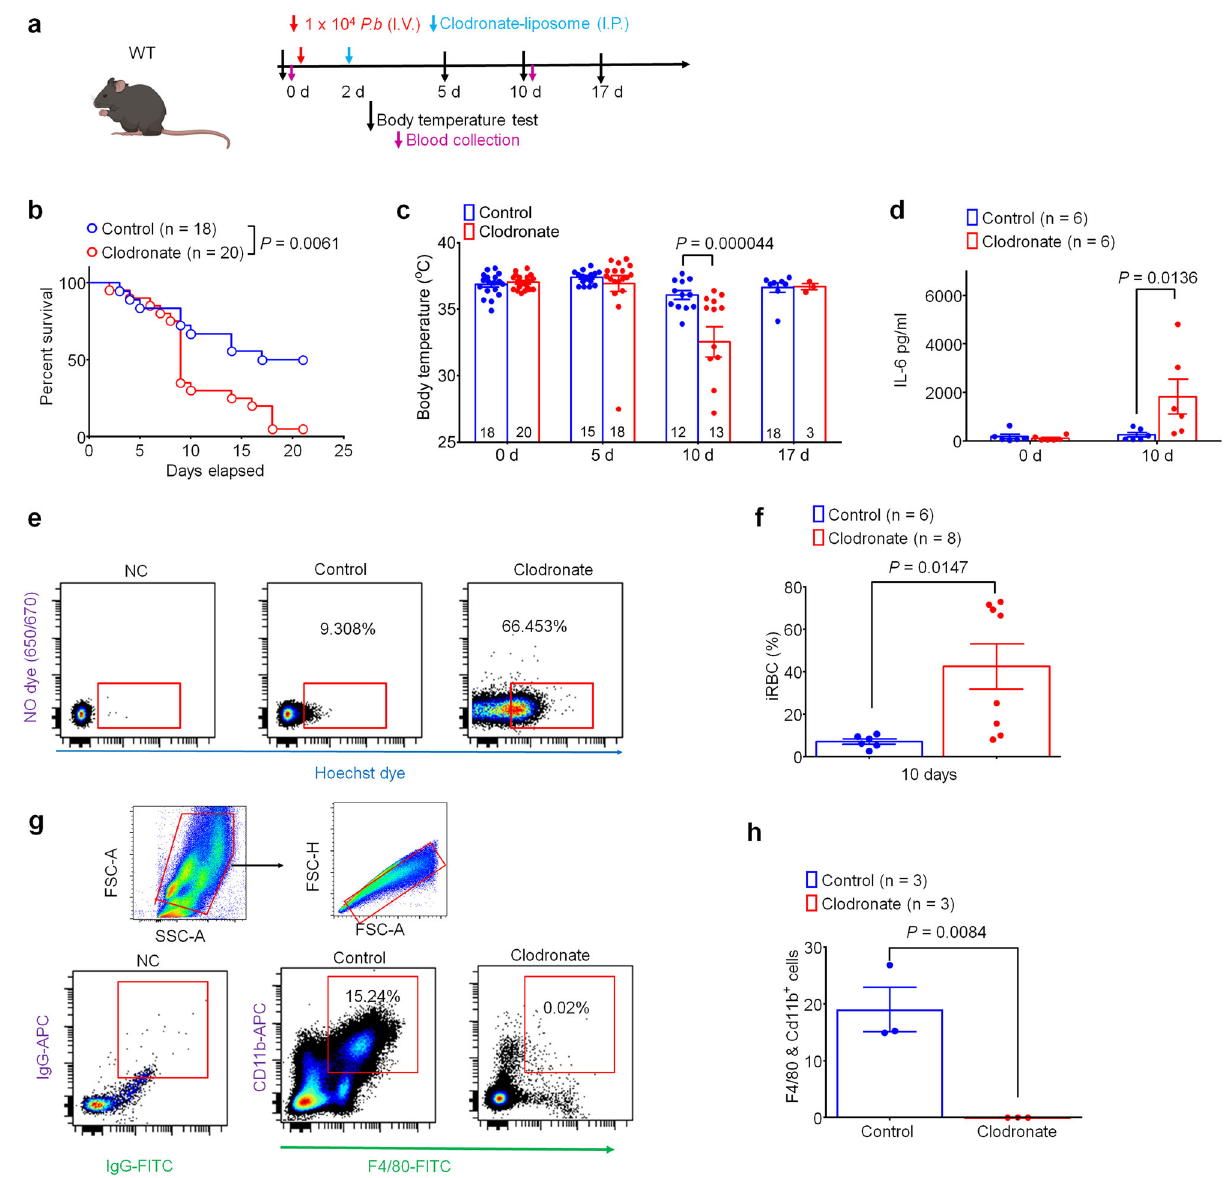
Fig. 6 Macrophages confer protection in the P.b. mouse model of malaria. a Experimental design to deplete macrophages following P.b . inoculation using clodronate liposomes (100 µ l I.P.) in WT mice. b Survival curves of control liposome or clodronate liposome-treated mice. Sample sizes are indicated in brackets. c Time course of rectal temperature in control- or clodronate-liposome-treated mice. Sample sizes indicated in columns. d Serum IL-6 levels in control- or clodronate liposome-treated mice 10d after P.b . inoculation ( n = 6/group). e , f Flow cytometry analysis to measure the proportion of P.b . infected RBCs (iRBCs) 10 d after inoculation, determined by positive staining following incubation with Hoechst dye (1 μ g/ml) and negative staining for NO dye (650/670, 2 µ l). e Representative images of fl ow cytometry results. (see gating strategy in Supplementary Fig. 4d). f Quanti fi cation of iRBCs (Hoechst + RBCs/total RBC) 10 d after P.b . inoculation in control liposome- or clodronate liposome-treated mice (1 × 10 6 RBC analyzed per sample, sample sizes indicated in brackets). g Representative fl ow cytometry images of peritoneal macrophages (Cd11b + /F4/80 + population) 5 d after control liposome or clodronate liposome administration, as in ( a ) ( n = 3 mice/group; 1 × 10 5 cells analyzed per sample) with gating strategy. h Quanti fi cation of peritoneal macrophages in control liposome- or clodronate liposome-treated mice. Data are expressed as mean ± s.e.m. and statistically analyzed by Mantel – Cox test ( b ), Two-way ANOVA followed by Bonferroni ’ s post-hoc test ( c , d ), or unpaired two-tailed t -test ( f , h